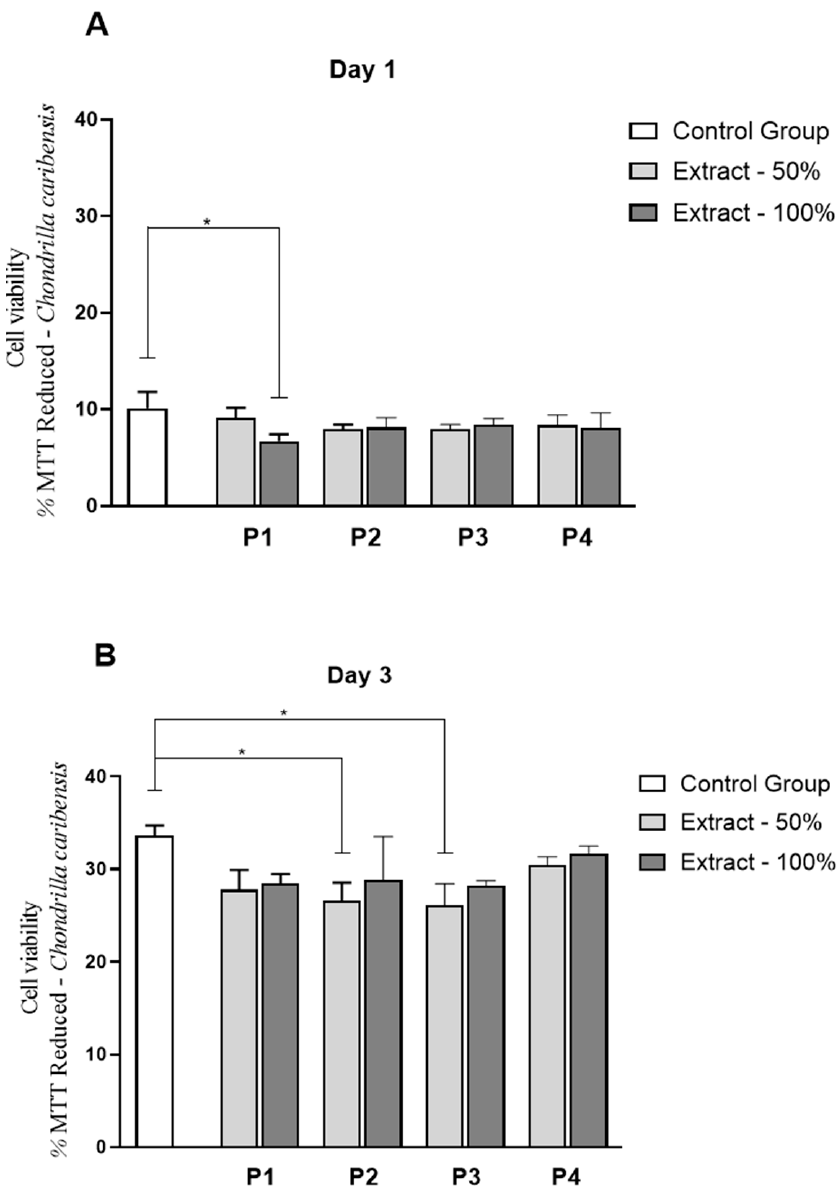
Figure 10. Viability L929 cell line by MTT assays in solution containing extracts of C. caribensis marine sponge species at experimental periods of 1 day ( A ) and 3 days ( B ). * p < 0.001 (Anova/Tukey test). Interestingly, for A. fulva extracts, a significant reduction in fibroblast cell proliferation was observed for all the extracts, at 50 and 100% compared to control, on days 1 and 3 of culture ( p < 0.0001) (Figure 11A,B). No statistically significant differences among the experimental groups were